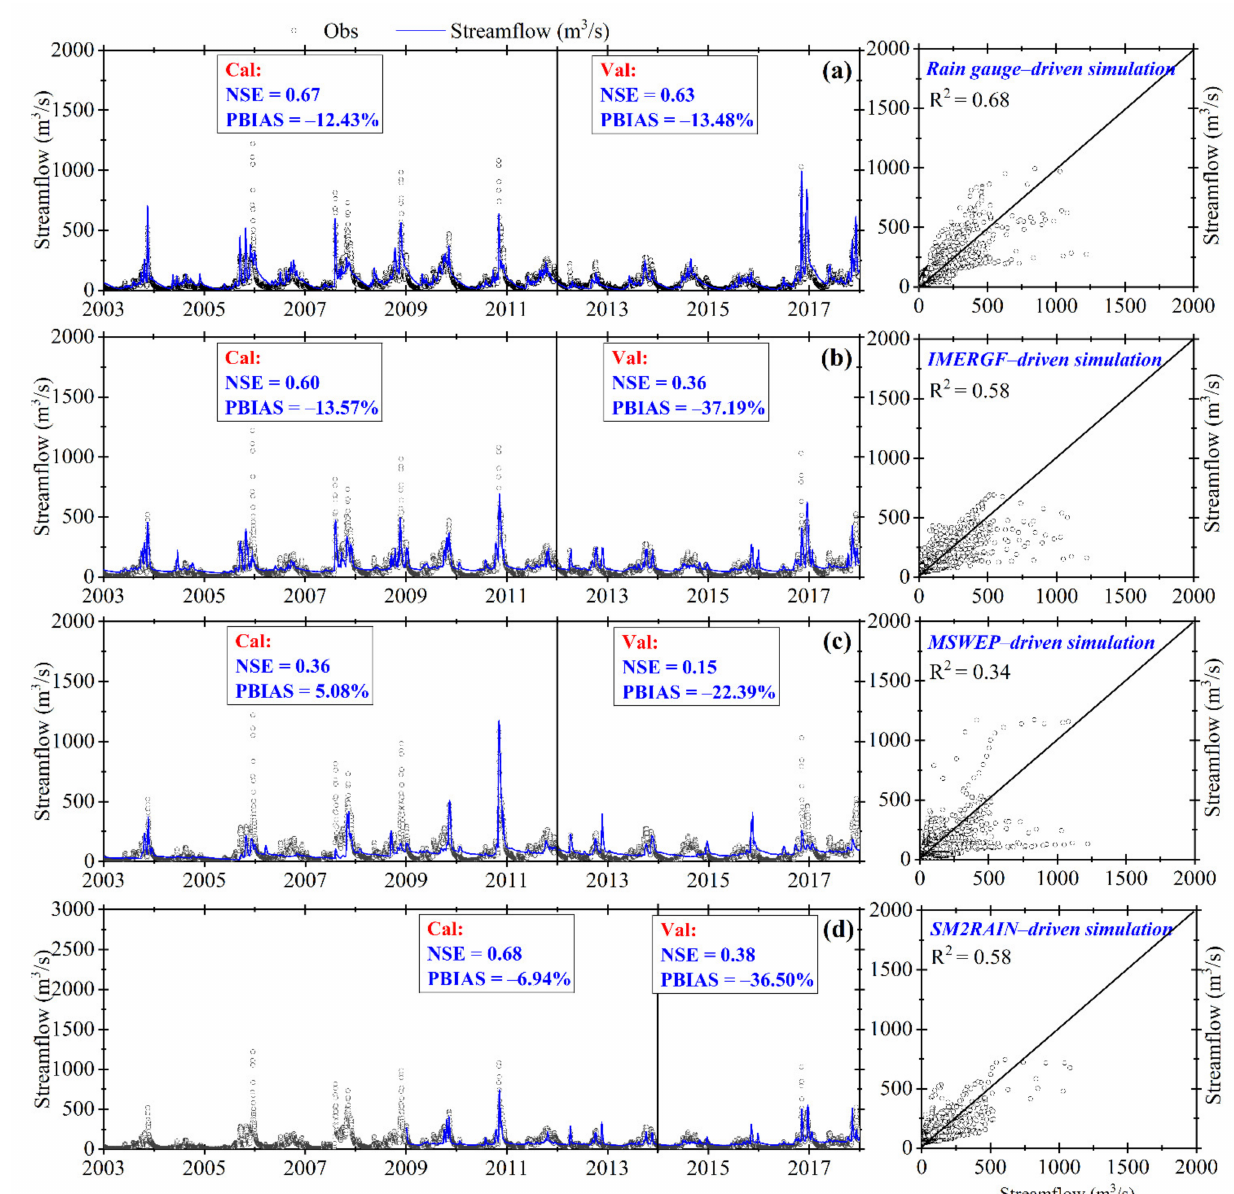
Figure 9. Performance of daily simulated streamflow compared to observed streamflow, performed by ( a ) rain gauge, ( b ) IMERGF-V6, ( c ) MSWEP, and ( d ) SM2RAIN–ASCAT, at the SRB, during